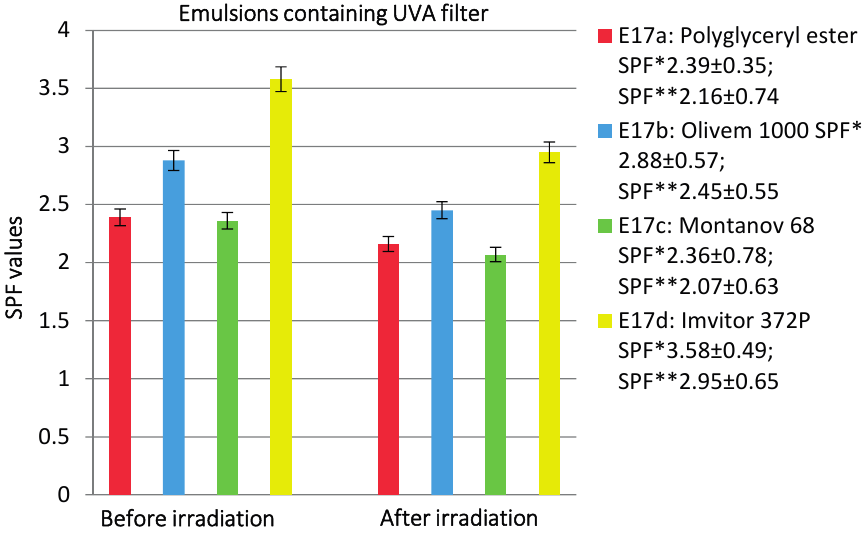
Figure 9. The effect of different emulsifiers on SPF values and photostability after irradiation at 20 MED of emulsions containing UVA filter. SPF *: SPF value before irradiation; SPF **: SPF value after irradiation.